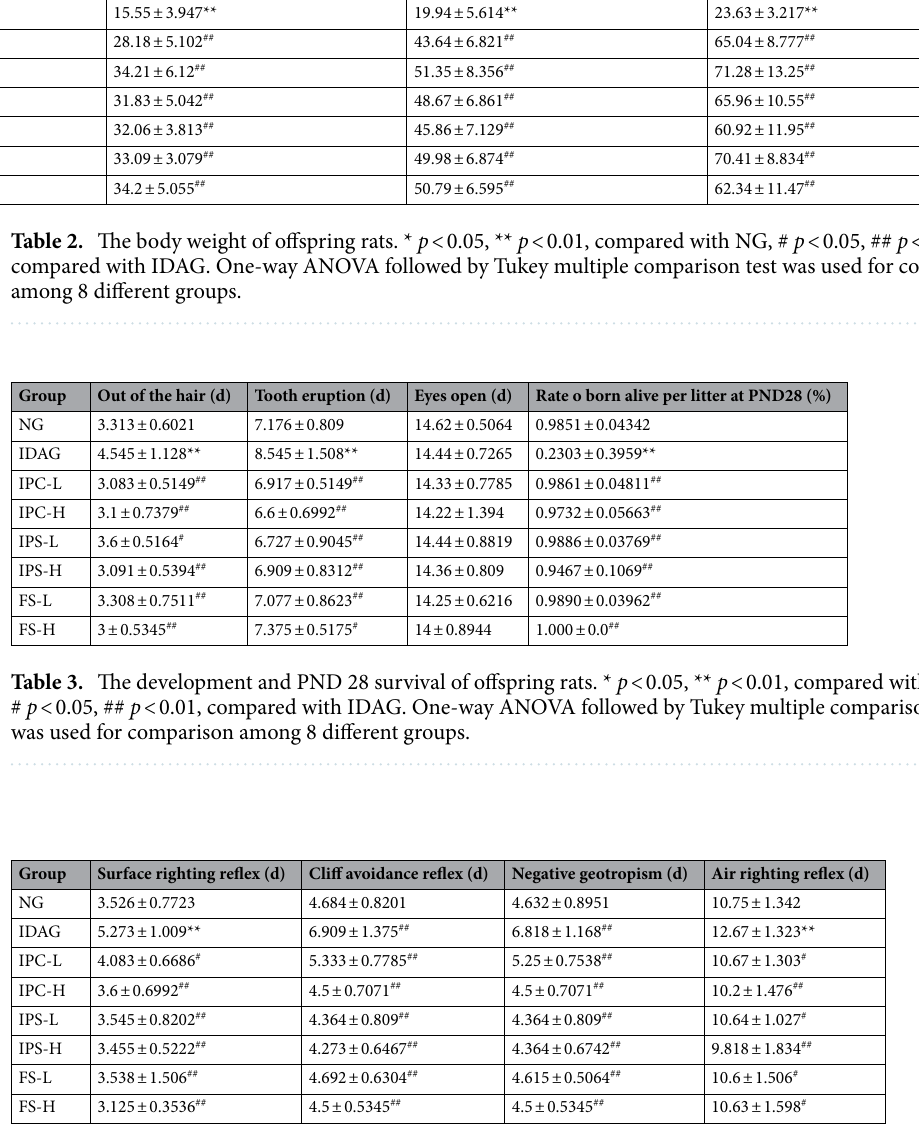
Table 4. The nerve growth and development of offspring rats. * p < 0.05, ** p < 0.01, compared with NG, # p < 0.05, ## p < 0.01, compared with IDAG. One-way ANOVA followed by Tukey multiple comparison test was used for comparison among 8 different